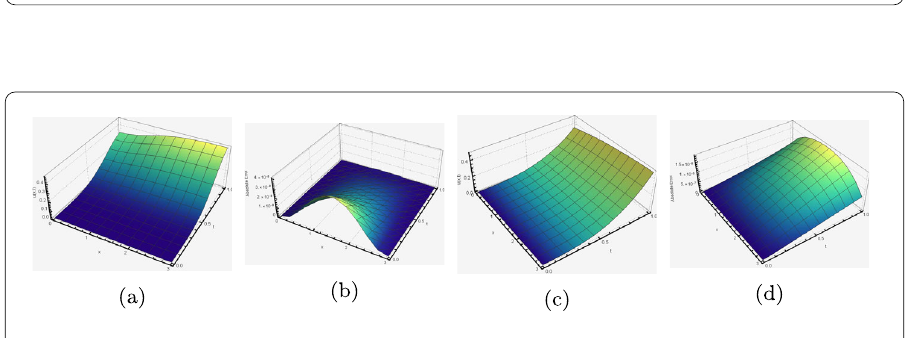
Figure 11 ( a ) and ( b ) represent approximate solution and absolute error distribution, respectively, using SJSCM. ( c ) and ( d ) represent approximate solution and absolute error distribution, respectively, using the non-polynomial B-spline method of Example 2 at α 1 = α 2 = 0.2, N = 11, 0 ≤ x ≤